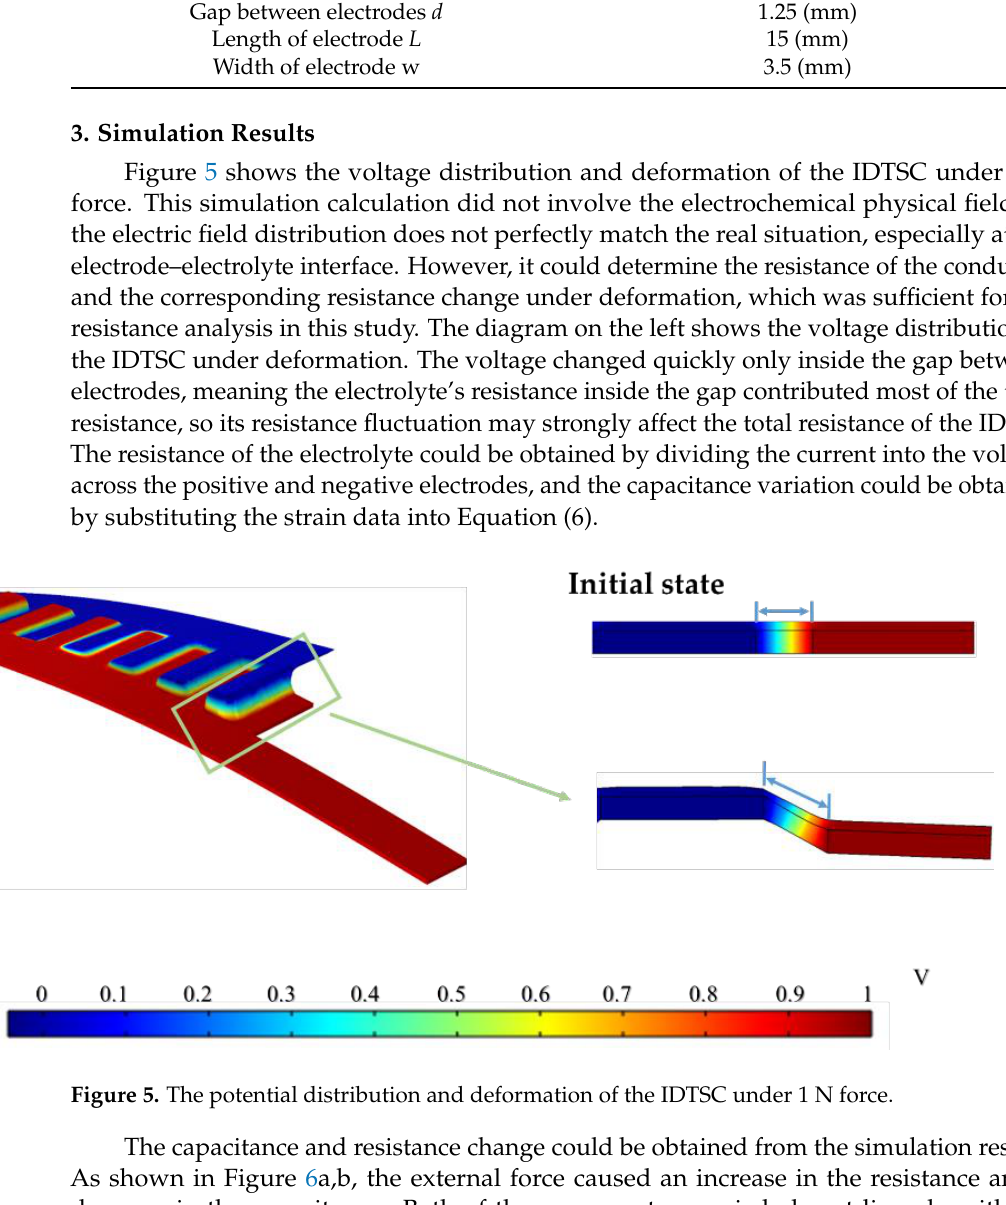
Figure 6. Simulation results: ( a ) R 0 / R vs. external forces; ( b ) C / C 0 vs. external forces; ( c ) RC / R 0 C 0 vs. external forces. Since the structural and dimensional parameters are physical quantities that can be easily controlled in the processing, certain structural and dimensional parameters were investigated in the simulations. The number of fingers ( N ) is an important structural parameter for an interdigital- type supercapacitor; thus, we first calculated the influence of N , as shown in Figure 7a,b. Obviously, a smaller N increased the changes in R and RC : at the given ranges of N (from 8 to 12), R 0 / R ranged from 0.947 to 0.979, and RC / R 0 C 0 ranged from 1.043 to 1.017 (at 1 N). This was probably because the subjecting of more fingers to the external force resulted in a lower average strain on each finger. According to Equation (8), increasing N helps to improve the linearity of the current response, because RC changes ony slightly. However, it may significantly increase the size of the device, so a trade-off is required in practical applications.